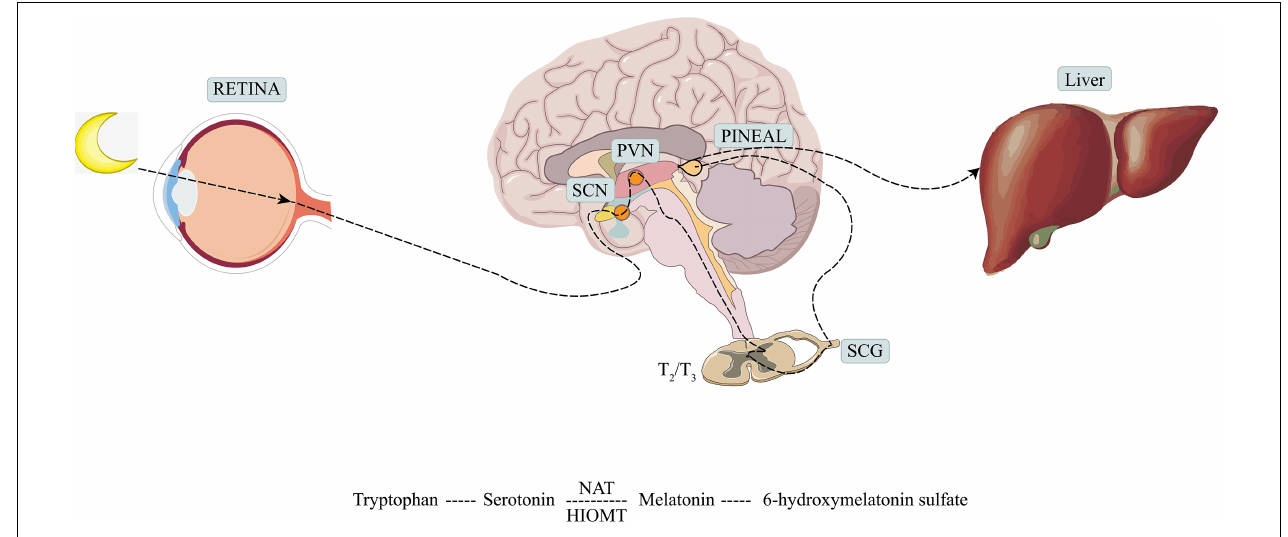
FIGURE 1 | Production and metabolism of melatonin. SCN, suprachiasmatic nucleus; PVN, paraventricular nucleus; SCG, superior cervical ganglion; NAT, serotonin- N -acetyl transferase; HIOMT, hydroxy indole- O -methyl transferase.